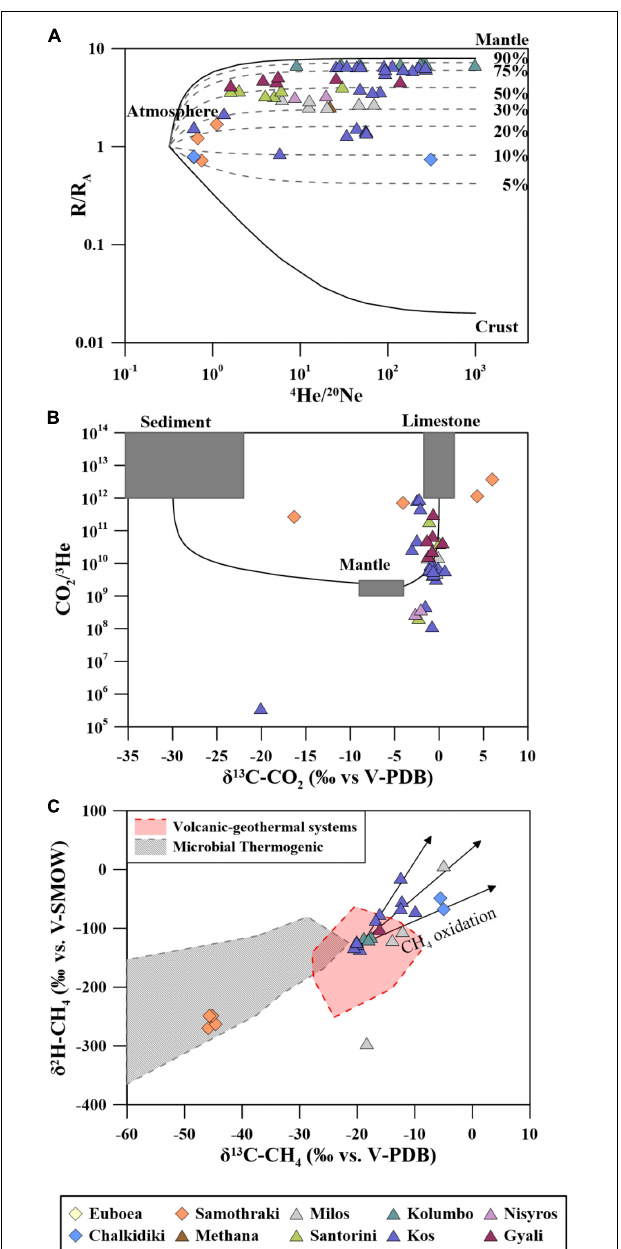
Table 2 . Details on the sampling techniques and the laboratory methods used are found in Methods section in Supplementary Data Sheet 1 . FIGURE 7 | Binary plot of (A) R/R A vs.